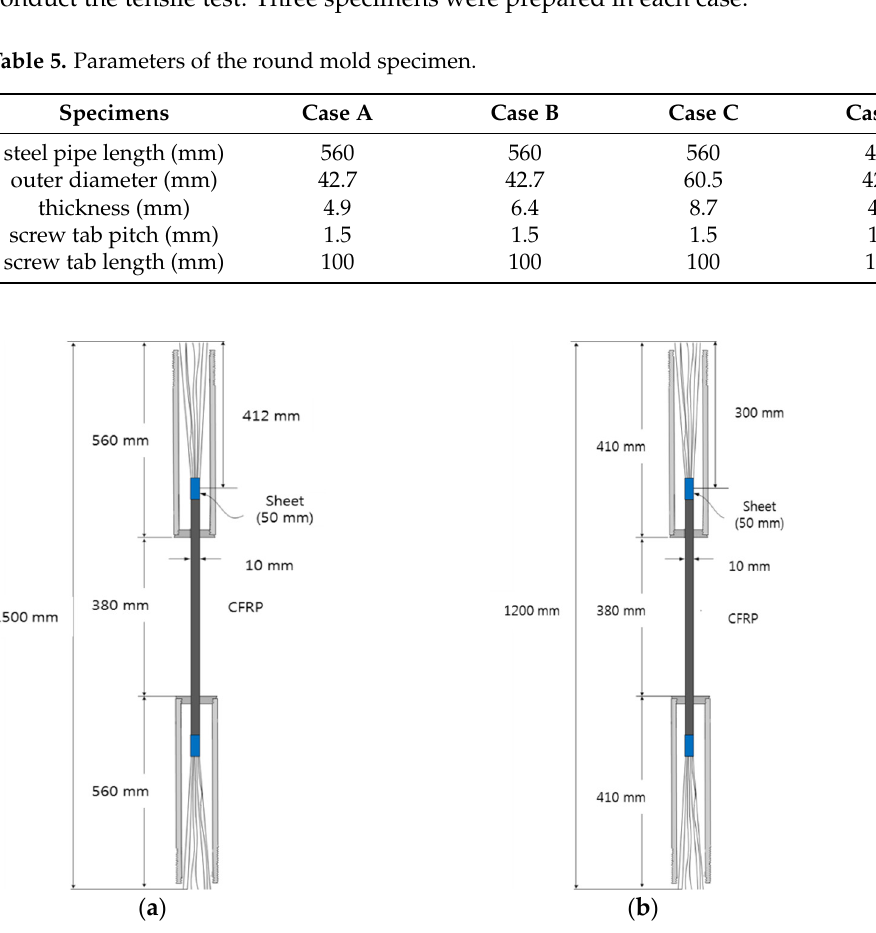
Figure 10. Specimen dimensions with respect to the steel pipe parameters: ( a ) Cases A–C, and ( b ) Case D.